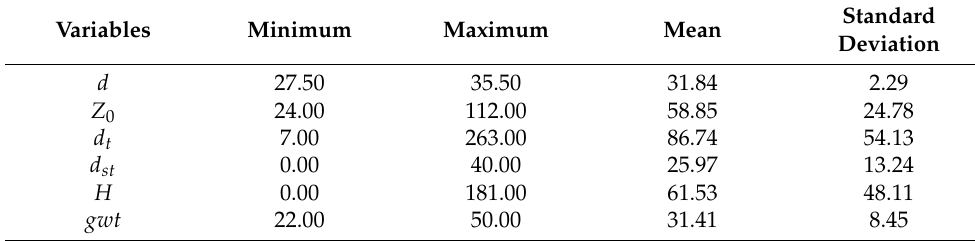
Table 2. Characteristic parameters and ranges of values in feet for parametric analysis.